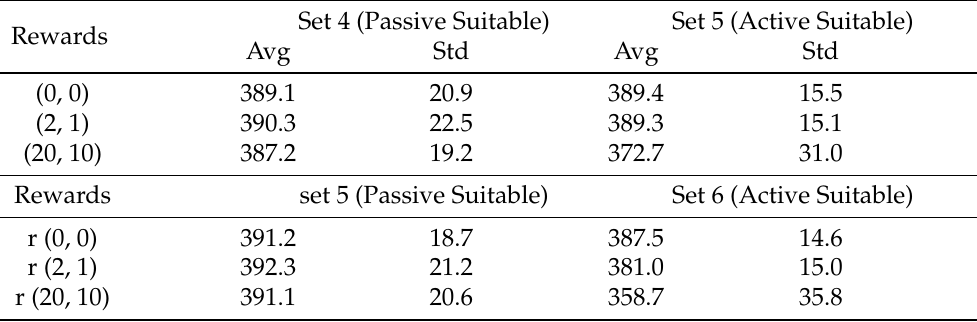
Table 4. Number of forward selection in the last 10,000 episodes of set (pairs are the cooperative rewards given).